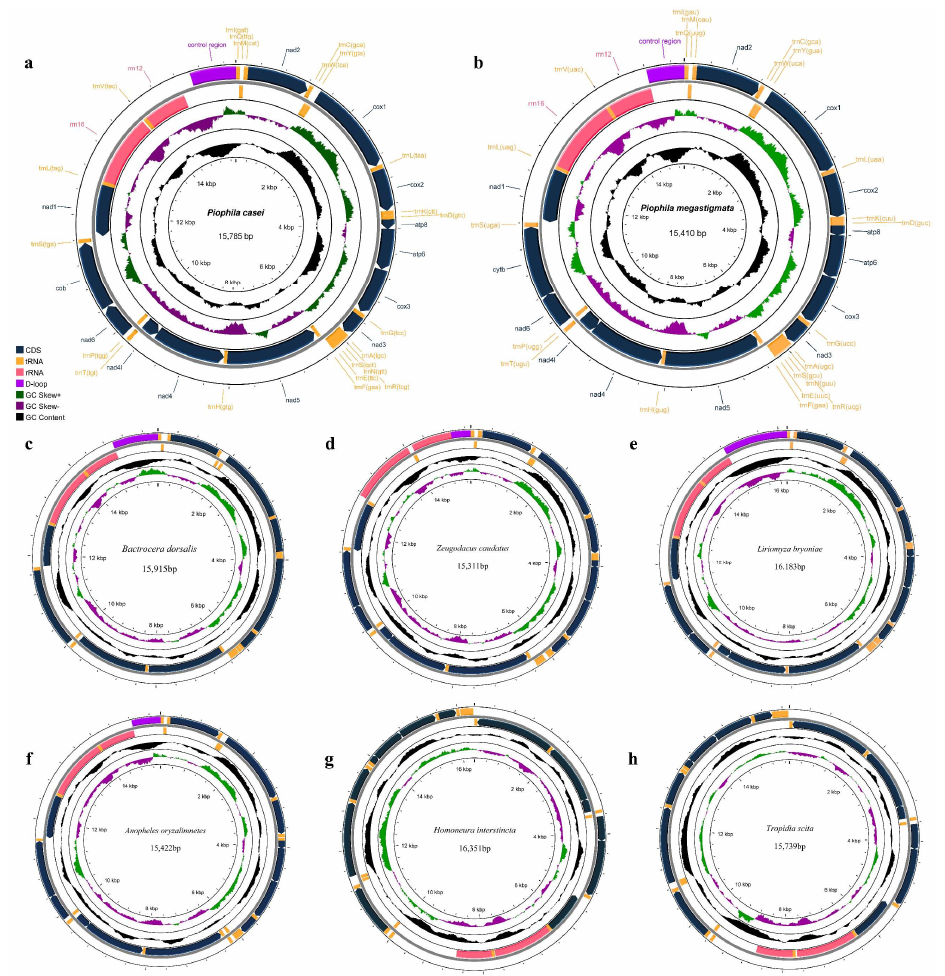
Figure 1. The mt genome of eight species. ( a ) P. casei , ( b ) P. megastigmata , ( c ) B. dorsalis , ( d ) Z. caudatus , ( e ) L. bryoniae , ( f ) A. oryzalimnetes , ( g ) H. interstincta , and ( h ) T. scita . The chain is marked with an arrow indicating the direction of gene transcription. Gene lengths correspond to nucleotide lengths in the diagram. The outermost layer is the J chain, and the second layer is the N chain. The third black peak indicates GC content, and the purple and green peaks indicate the ±skew of GC. The mitochondrial genomes of P. casei and P. megastigmata exhibit a high degree of conservation, as evidenced by the presence of 37 genes in each genome, as well as the absence of any inversion events or swapping of gene coding directions.